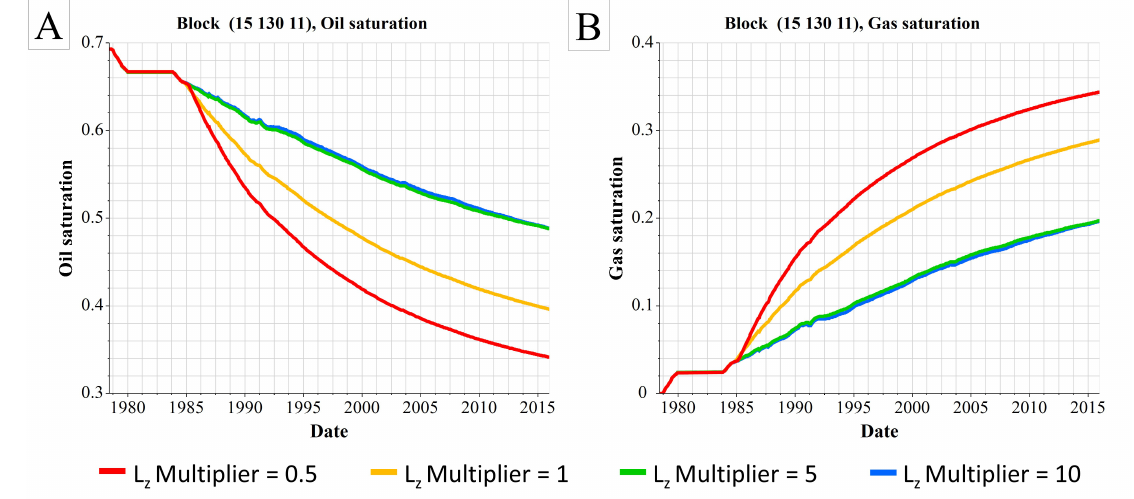
Figure 22. The effect of various matrix block heights on the oil saturation in the block (15 130 11), hence the oil recovery from the matrix